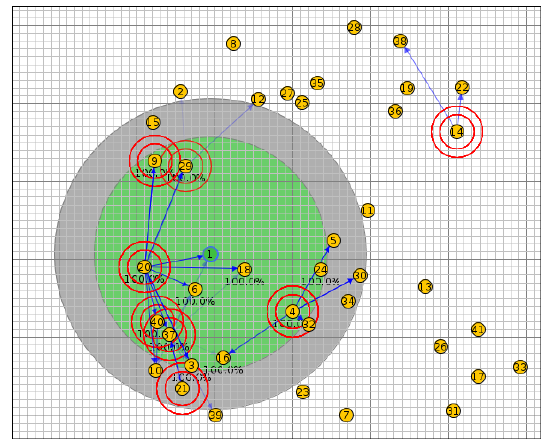
Figure 8. Scenario II with 40 nodes.